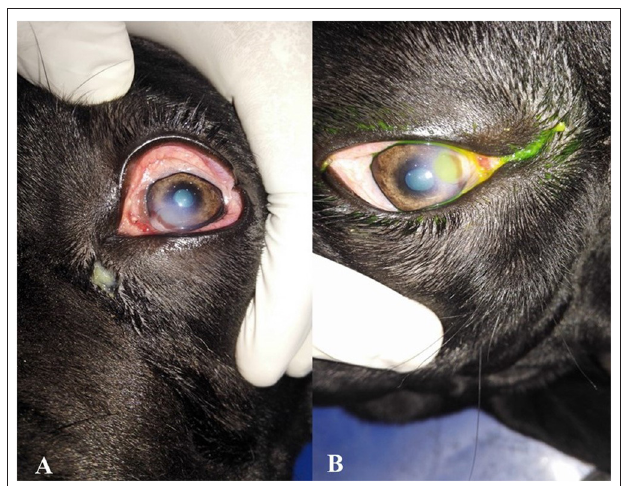
FIGURE 1 | Photographs showing the clinical diagnosis of the ulcer by fluorescent dye. (A) Eye suffered from corneal ulcer, (B) after application of fluorescent dye showing type and depth of corneal